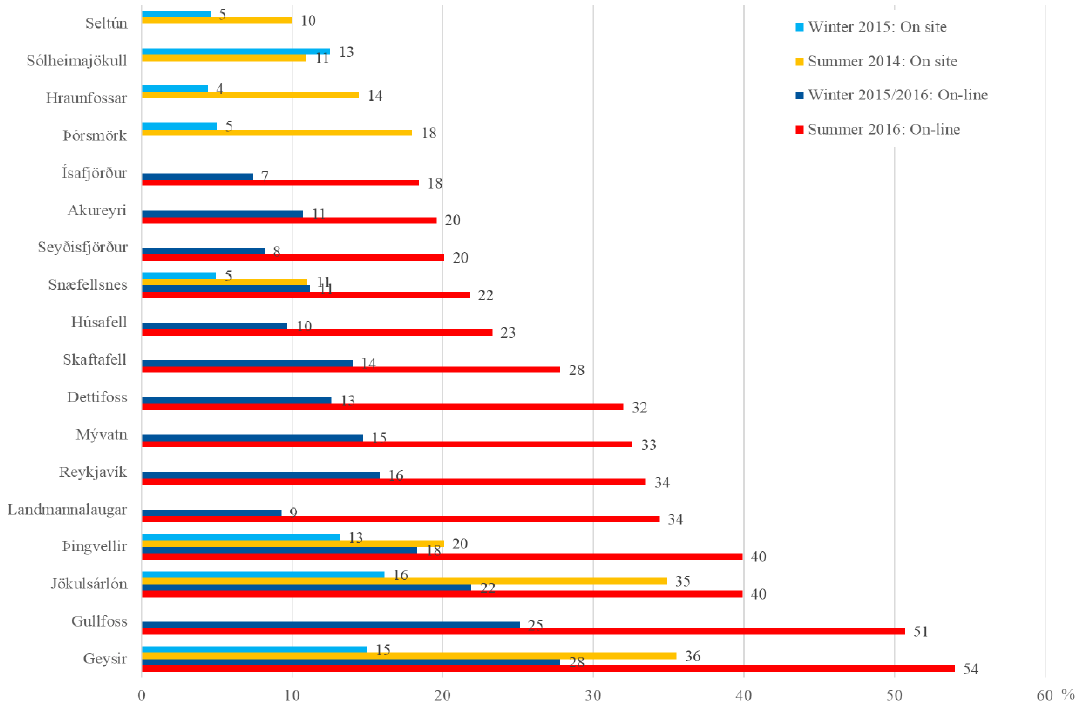
Figure 5. Proportion of visitors in summer and winter who consider the number of visitors as many or too many. Source: [83,87,89].